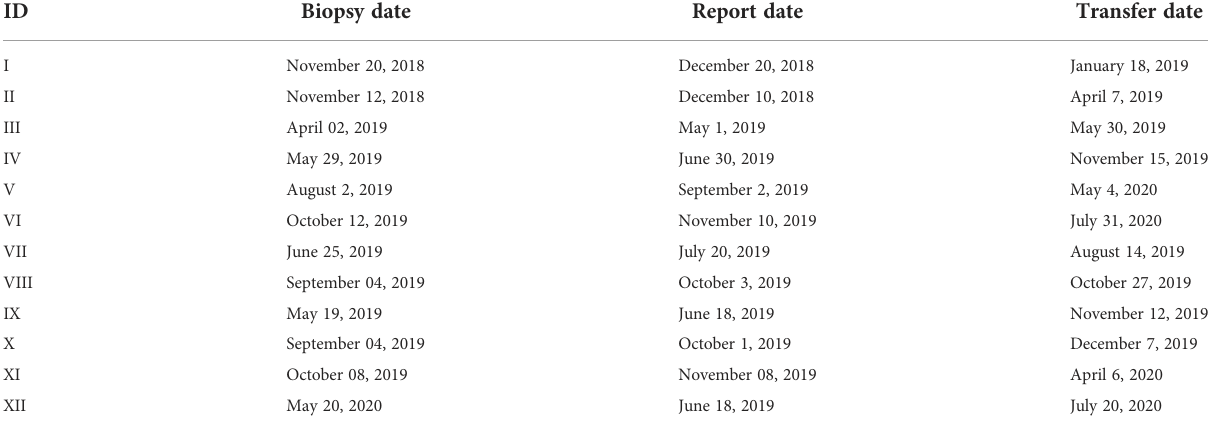
TABLE 3 Biopsy, report and transfer dates of 12 D7 euploid